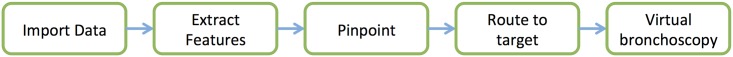
Bronchoscopy workflow as implemented in Fraxinus.Patient data is imported, then processed in several stages until virtual bronchoscopy can commence.